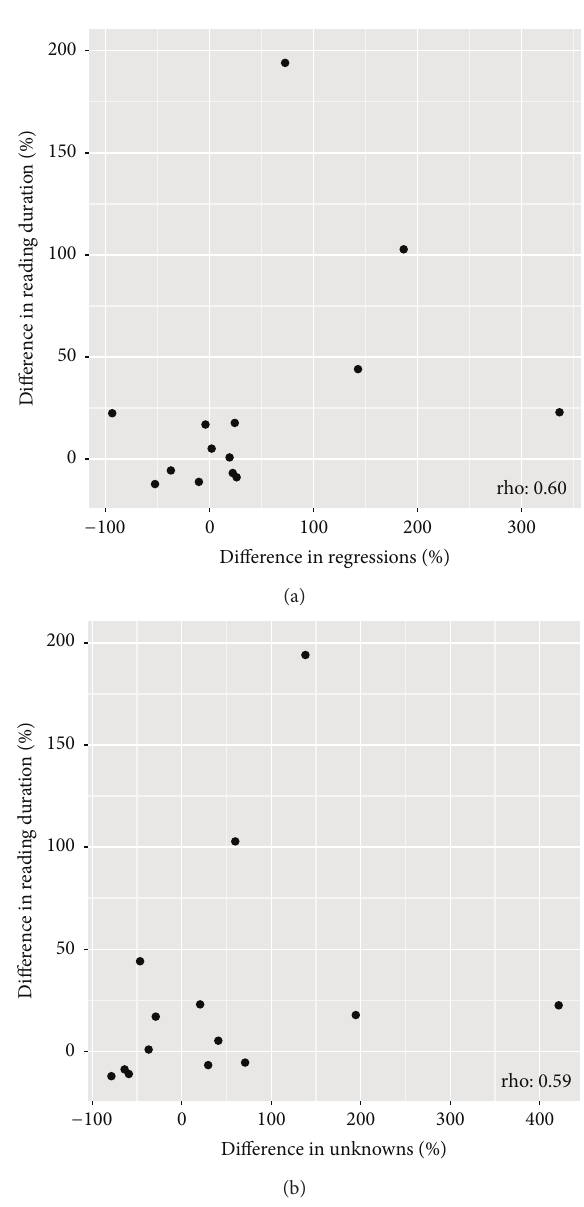
Figure 5: Scatterplots showing statistically significant relationships between the percentage difference in reading duration between the betterandworseeyeandthedifferencebetweenthebetterandworse eye in (a) the proportion of regressions and (b) the proportion of “unknown” eye